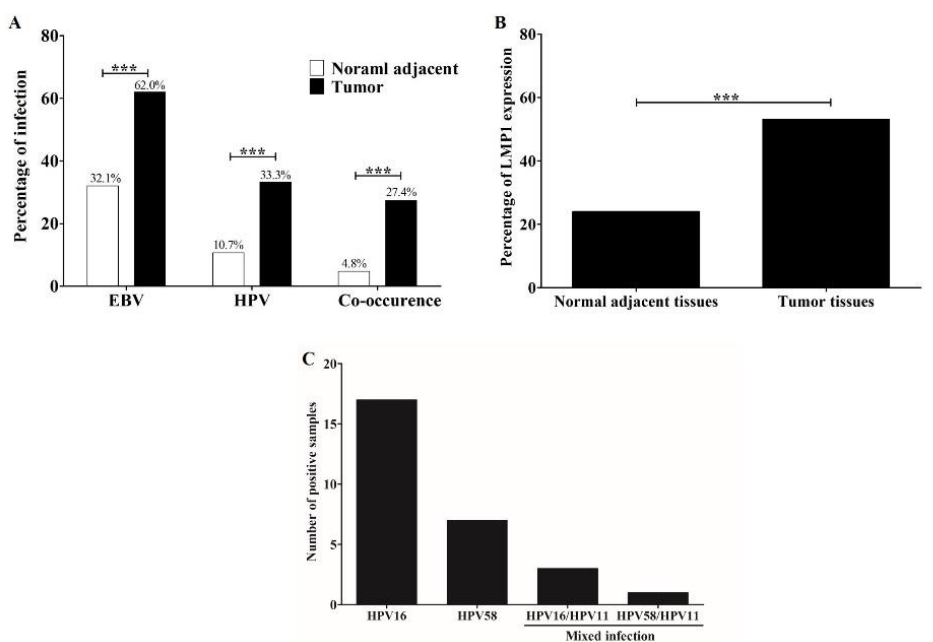
Figure 1. EBV and HPV infection is more frequently detected in OSCC tumor tissues than in normal tissues. Prevalence of HPV, EBV, and their co-occurrence in tumor and normal adjacent tissues ( A ). The LMP1 expression in tumor and normal adjacent tissues was determined by qRT-PCR ( B ). Distribution of HPV genotypes in OSCC tissues as determined by RLBH ( C ) ***: p < 0.001.